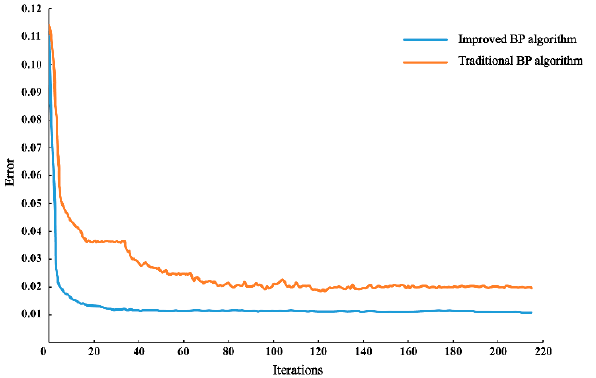
Figure 7. Iterative convergence curve for lightweight analysis between elastic modulus and meso Figure 7. parameters.